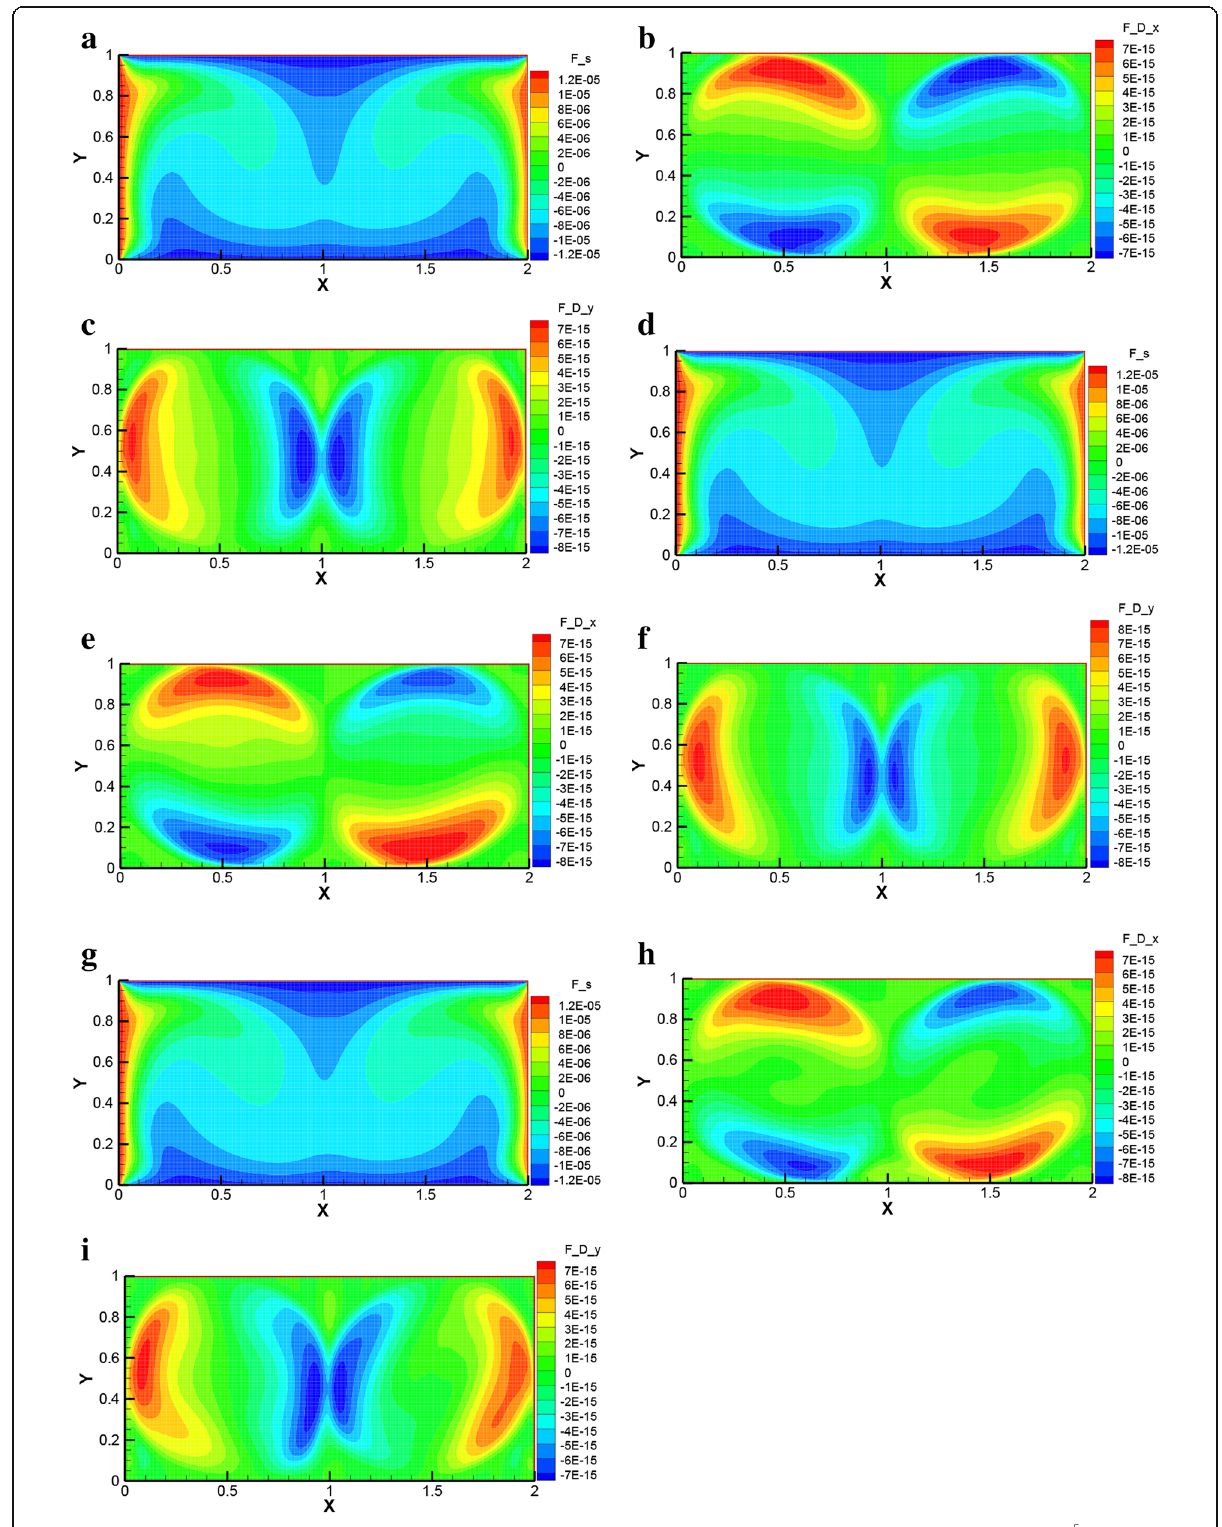
Fig. 4 Temperature difference driving force F S and drag force F D . Temperature difference driving force F S and drag force F D at Ra =1×10 5 ( A =2:1, r =20 nm). a F